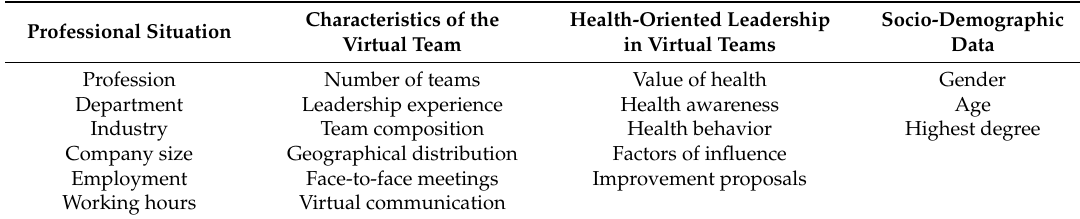
Table 1. Contents of the interview